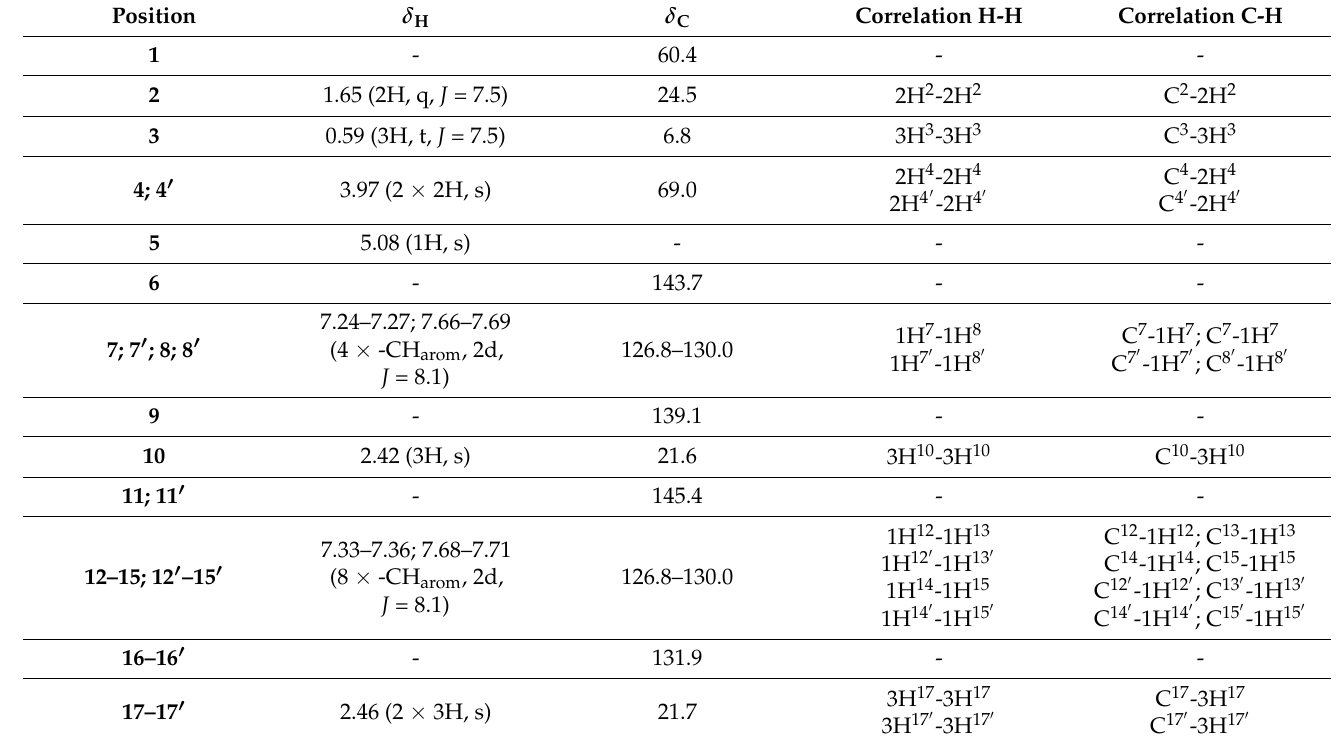
Table 1. 1 H (300 MHz) and 13 C (75 MHz) NMR spectral data for compound ( 2 ) in CDCl 3 , including results obtained by homonuclear 2D-shift-correlated and heteronuclear 2D-shift-correlated HMBC. Chemical shifts ( δ in ppm) and coupling constants ( J in Hz).